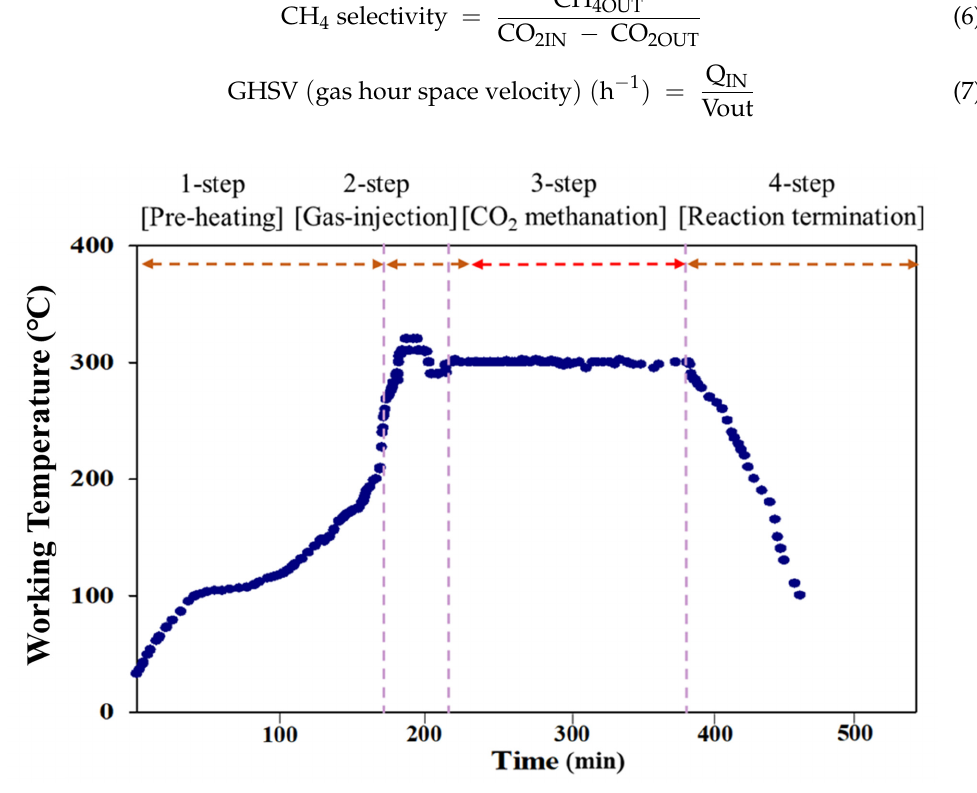
Figure 11. Four steps of the CO 2 methanation process.